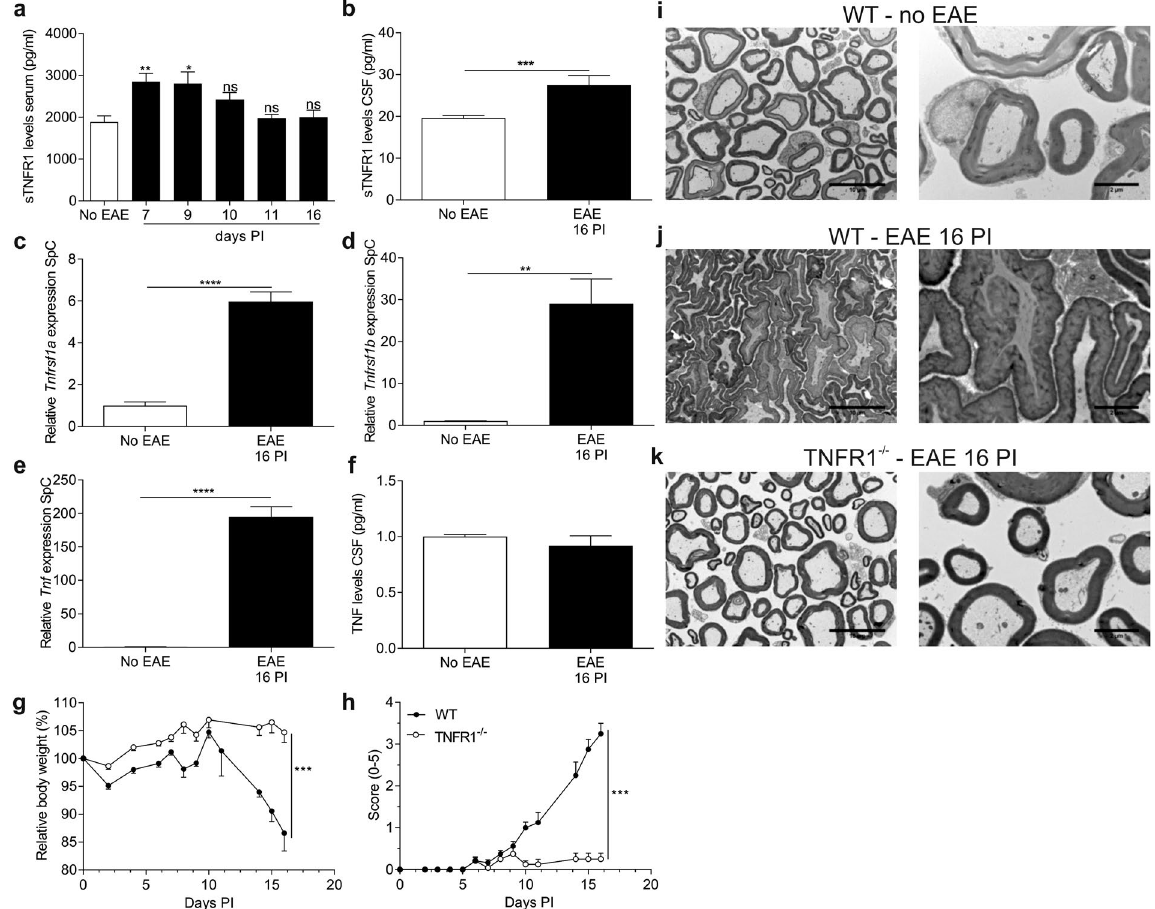
Figure 2. ( a – k ) TNFR1 involvement in experimental autoimmune encephalomyelitis (EAE). Wild type (WT) and TNFR1 − / − mice were immunized with MOG 35-55 peptide and pertussis toxin to induce EAE. ( a ) Soluble TNFR1 (sTNFR1) serum levels were determined by ELISA 7, 9, 10, 11 and 16 days post-immunization (PI) in WT mice and compared to healthy mice (no EAE) (n = 6 ‒ 10). ( b ) sTNFR1 levels were determined by ELISA in cerebrospinal fluid (CSF) 16 days PI from WT mice (n = 4) and compared to healthy WT mice (no EAE, n = 8). ( c – e ) Spinal cords (SpC) were isolated 16 days PI from WT mice (n = 4) and fold induction of Tnfrsf1a, Tnfrsf1b and Tnf were determined by qPCR and compared to healthy WT mice (no EAE, n = 4). ( f ) TNF levels were determined in CSF 16 days PI from WT mice (n = 4) and compared to healthy mice (no EAE, n = 8). ( g,h ) WT and TNFR1 − / − mice (n = 12/group) subjected to EAE were weighed and clinically scored daily. Relative body weight (relative to initial body weight) ( g ) and clinical disease scores (scale 0 ‒ 5) were assessed in all mice ( h ). ( i – k ) Conventional transmission electron microscopy (TEM) examination of peripheral nerves 16 days PI in healthy WT ( g,j ), EAE-diseased WT ( h,k ) and TNFR1 − / − mice ( i,l ) (n = 2/group). Representative images of each group are shown. Data information: qPCR was normalized to stable housekeeping genes. Bars represent mean ± SEM. Statistics were calculated with a one-way ANOVA test ( a ) or unpaired t test ( b–f ). Clinical scores during EAE were analyzed as repeated measurements using the restricted maximum likelihood (REML) variance components analysis. The TEM images were taken at a magnification of 1200x, scale bar 10 µ m ( g,h,i ), and 5000x, scale bar 2 µ m ( j,k,l ). * 0.01 ≤ p < 0.05; ** 0.001 ≤ p < 0.01; *** 0.001 ≤ p 0.0001, **** p <